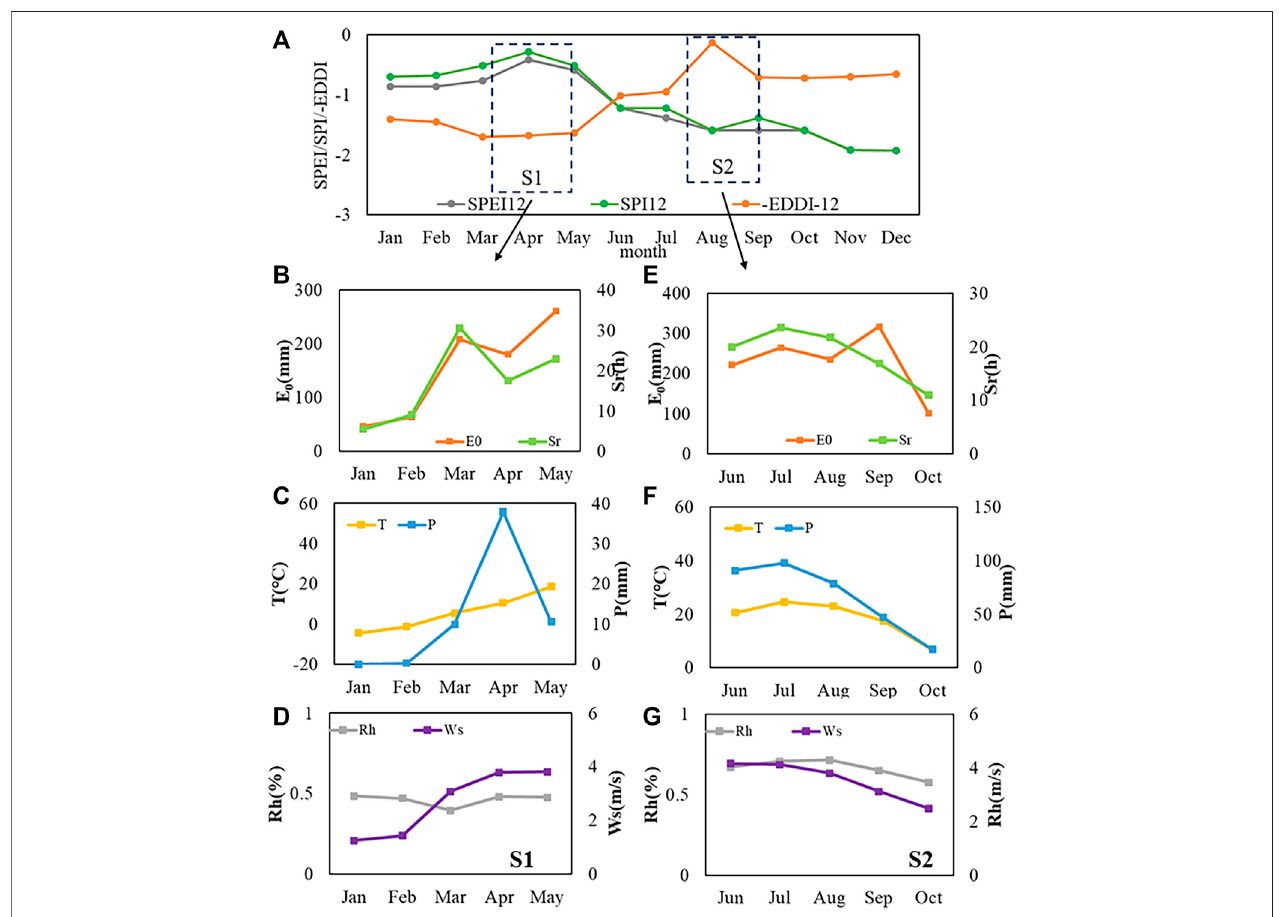
FIGURE 6 | Temporal variations in the SPEI, SPI, EDDI (A) , and driving factors in different situations (situation 1 (S1) and situation 2 (S2)) in 2002. Among them, (B – D) and (E – G) representEvaporationdemand(E0)andSolarradiation(Sr);Temperature(T)andPrecipitation(P);Relativehumidity(Rh)andWindspeed(Ws)inS1and S2